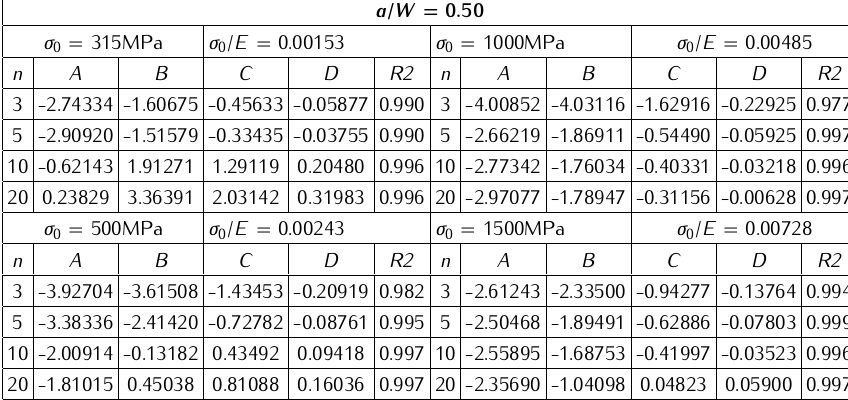
Table 10. The coefficients of equation (13) for SEN(T) specimen with the crack length a / W =0.50.